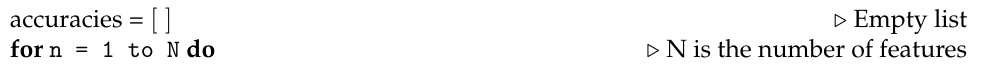
Algorithm 2 Basic steps for determining the best training settings for the model using PCA. accuracies = [